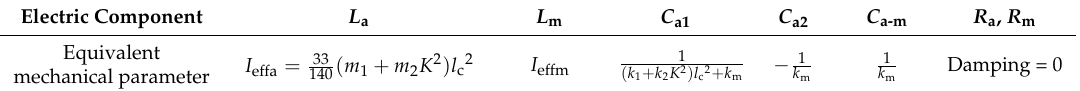
Figure 4. Amplitude spectrums of modelling and ( b ) FEM simulations (I: current of the equivalent circuit and u : velocity of actuator and mirror plate.)